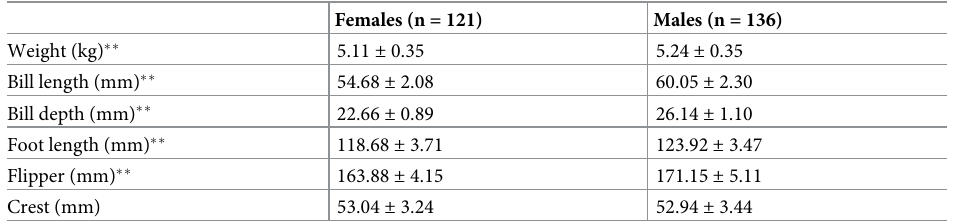
Table 1. Results of morphometric measurements from 121 females and 136